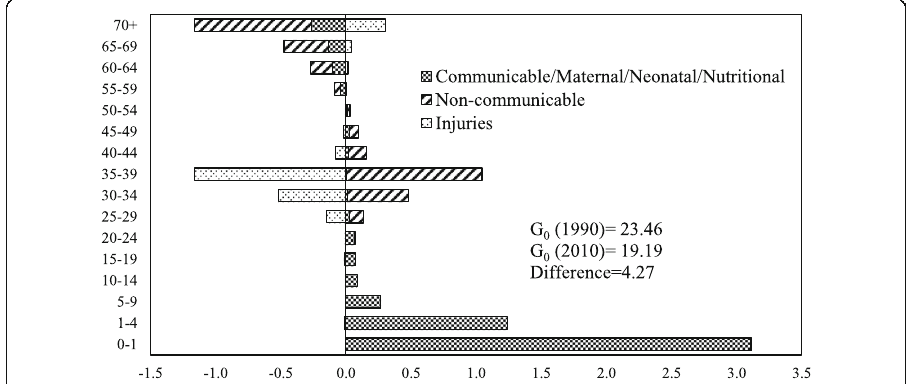
Fig. 4 Decomposition of the differences in Gini coefficient between 1990 and 2010 by age and cause of death, men,